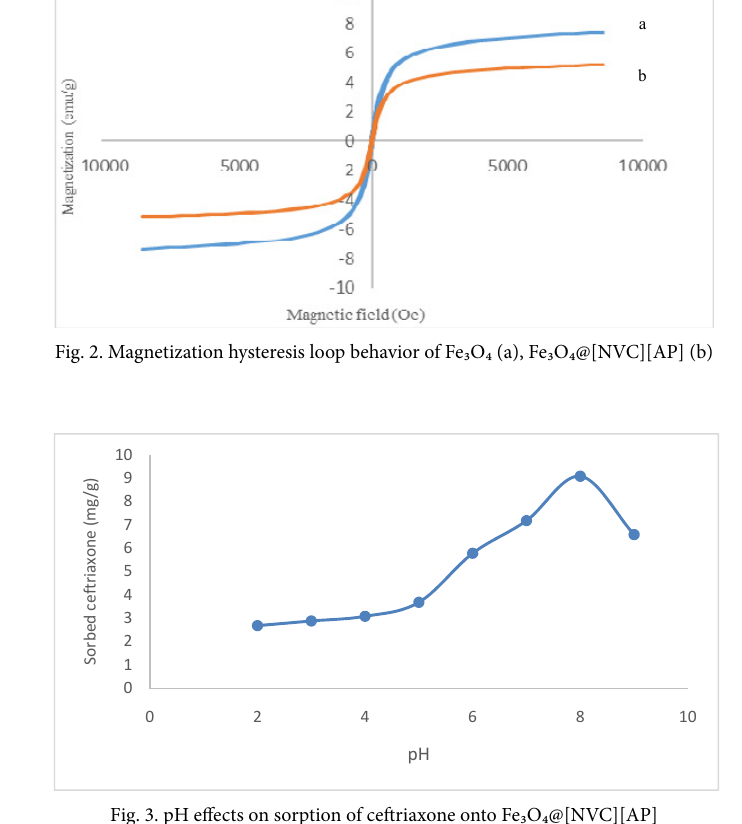
Fig. 3. pH effects on sorption of ceftriaxone onto Fig.3. pH effects on sorption of ceftriaxone onto Fe